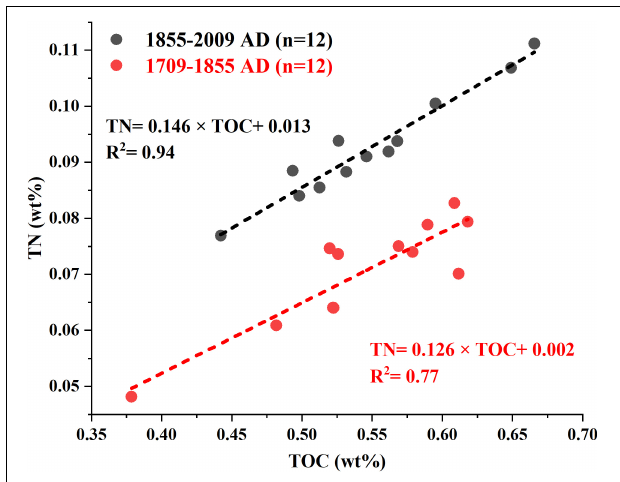
FIGURE 7 | Total nitrogen (TN) versus total organic carbon (TOC) in core HH12. Two data at 1728 AD and 1740 AD overlapped in this